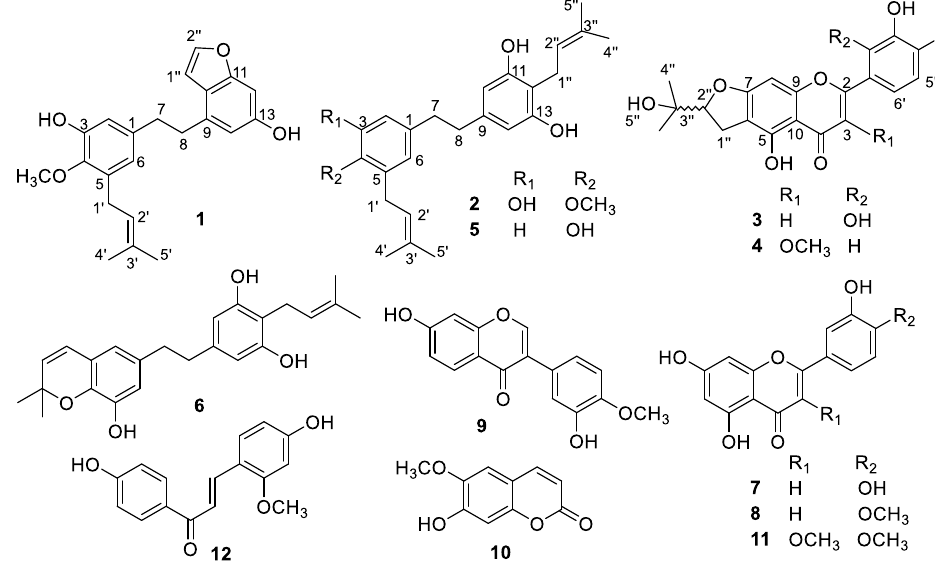
Figure 1. Structures of compounds 1 – 12 from G. uralensis.